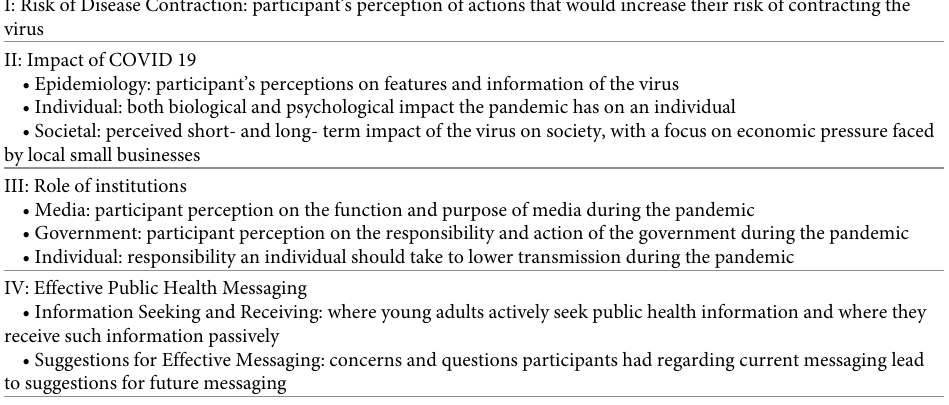
Table 3. Overview of